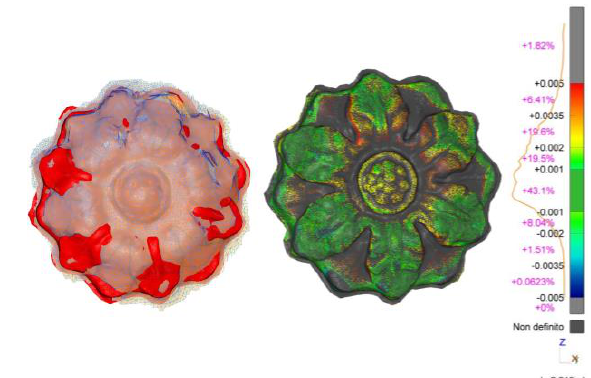
Figure 10. Comparison between the meshs of F6 medium range (yellow) and F6 short range (red)